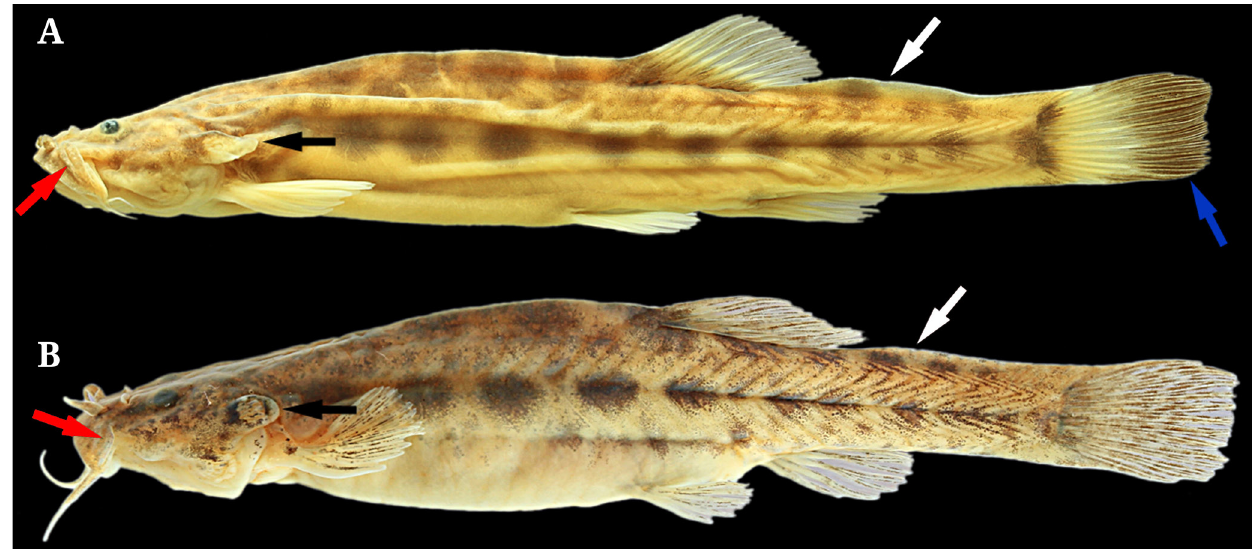
FIGURE 1 | Lateral view of A. Scleronema macanuda , new species, paratype (ZVC-P 9374; 74.5 mm SL) and B. S. milonga , new species, holotype (MCP 54165; 37.8 mm SL) showing the thick fleshy flap in the base of the maxillary barbel (red arrows), the skin flap in the posterior margin of the opercle (black arrows), the dorsal membrane in the caudal peduncle (white arrows), and the vertical black bar in the caudal fin (blue